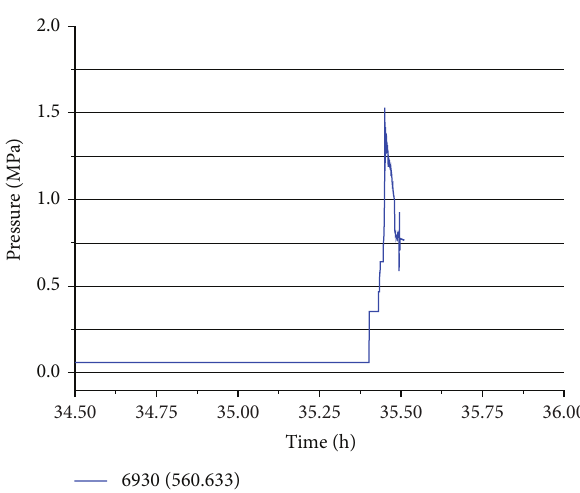
Figure 9: Numerical result of the impulse pressure for the field trial.